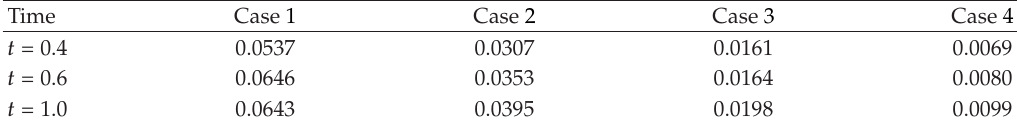
Table 2: L 2 -norm estimates of Z n − z n .